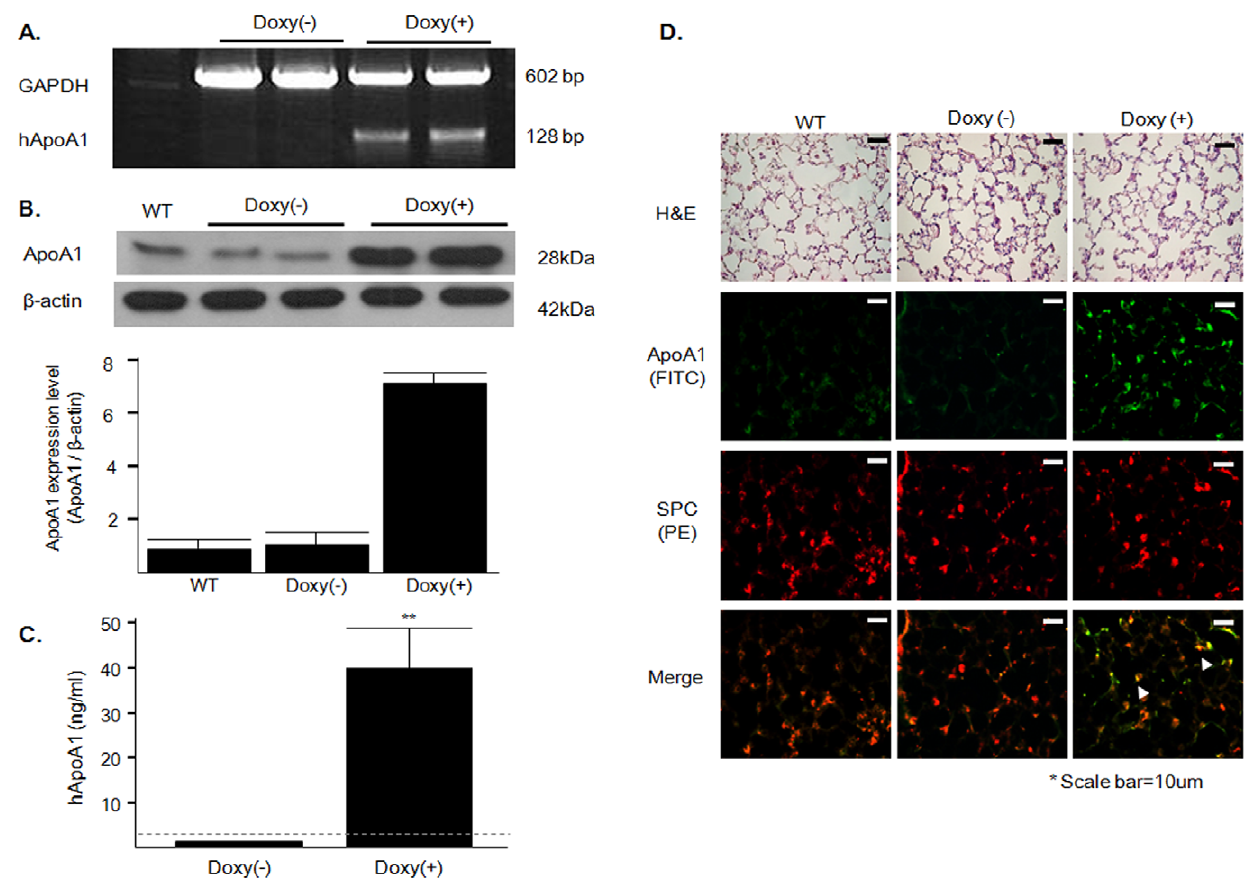
Figure 1. Generation of ApoA1 transgenic mice. Overexpression of hApoA1 was induced using doxycycline-containing drinking water (Doxy + ). Control mice were offered normal water (Doxy 2 ). ( A) RT-PCR analysis revealed hApoA1 mRNA only in the lungs of mice treated with doxycycline. ( B) ApoA1 protein expression was significantly greater in the lungs of doxycycline-treated transgenic mice compared with those of wild-type or transgenic mice not treated with doxycycline ( n =6 mice/group). ** p , 0.01 compared with WT or Doxy( 2 ) mice. (C) Detection of human ApoA1 in BAL fluids. ELISA was performed on the first 1-mL fraction of BAL fluid, with a detection limit of 3.13 ng/mL (dashed line). Values below the detection limit were treated as 0 ( n =6 mice/group). ** p , 0.01 compared with Doxy( 2 ) mice. (D ) Immunofluorescence analysis showed that ApoA1 was strongly expressed in the alveolar epithelium (white arrow heads) in the doxycycline-treated transgenic mice. Scale bar=10 m m. H&E, hematoxylin and